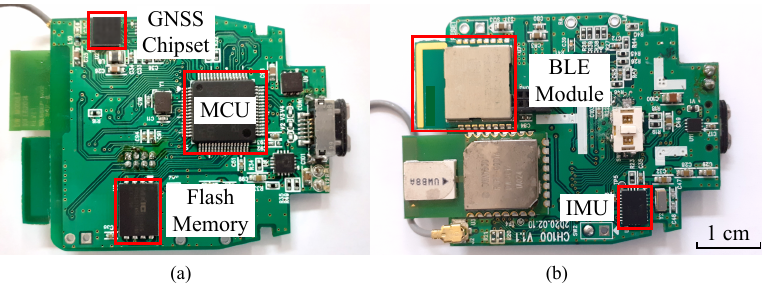
Figure 3. A circuit board of the proposed wearable EPTS device: ( a ) front-side and ( b ) back-side.